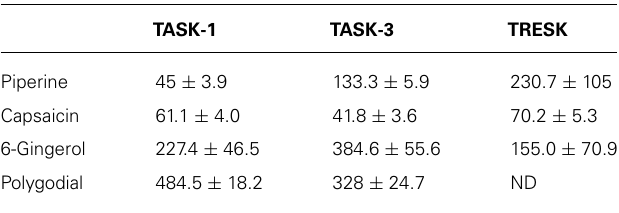
Table 1 | IC 50 values for pungent substances on human K 2P channels.